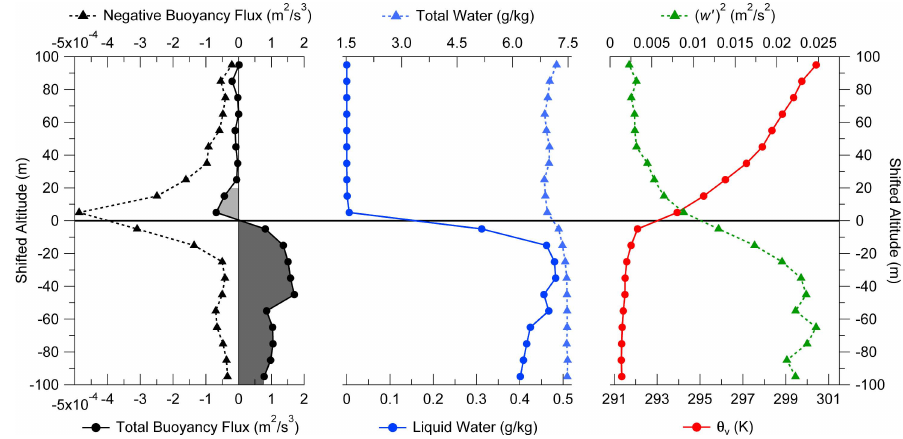
Fig. 2. Whole-flight averaged vertical profiles for 21 July 2008 of (left to right): the sum of only negative buoyancy fluxes; the net buoyancy flux (with altitudes of net negative and positive buoyancy fluxes shaded); total water; liquid water; (cid:0) w 0 (cid:1) 2 ; and virtual potential temperature. The vertical coordinate is the shifted altitude z s where the liquid water cloud top is defined as 0m.